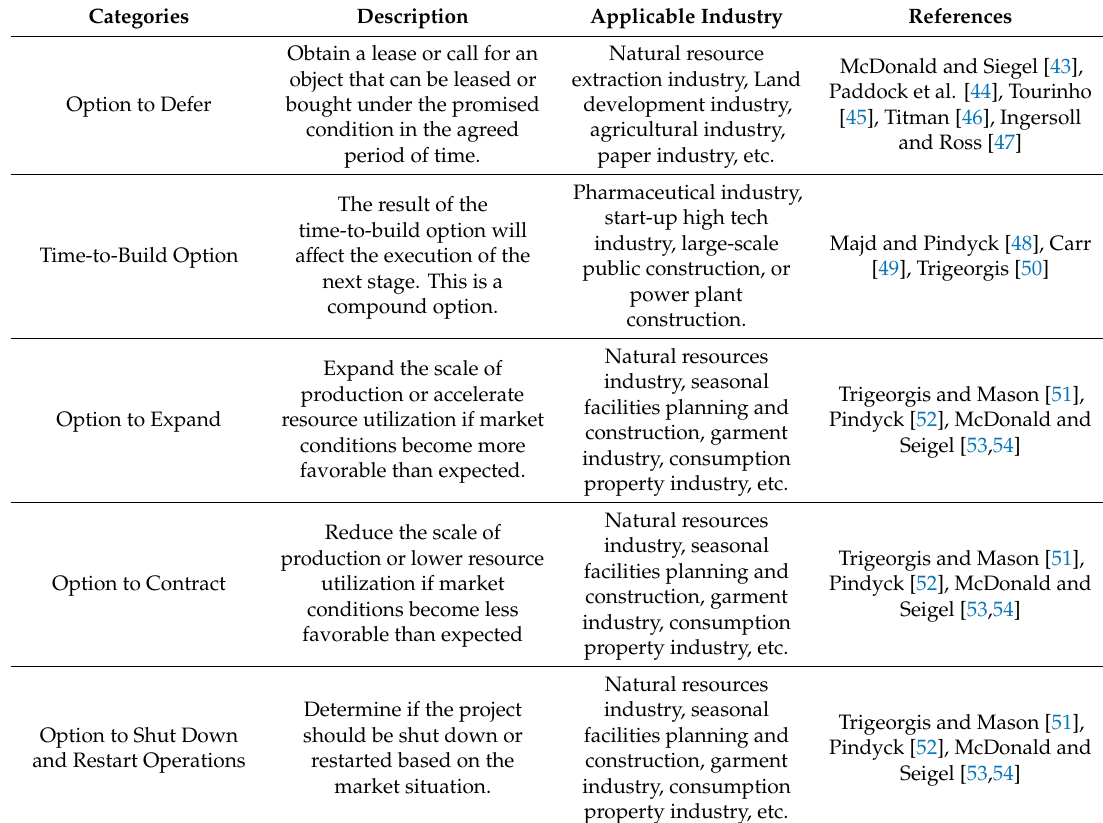
Table 2. Categories of Real